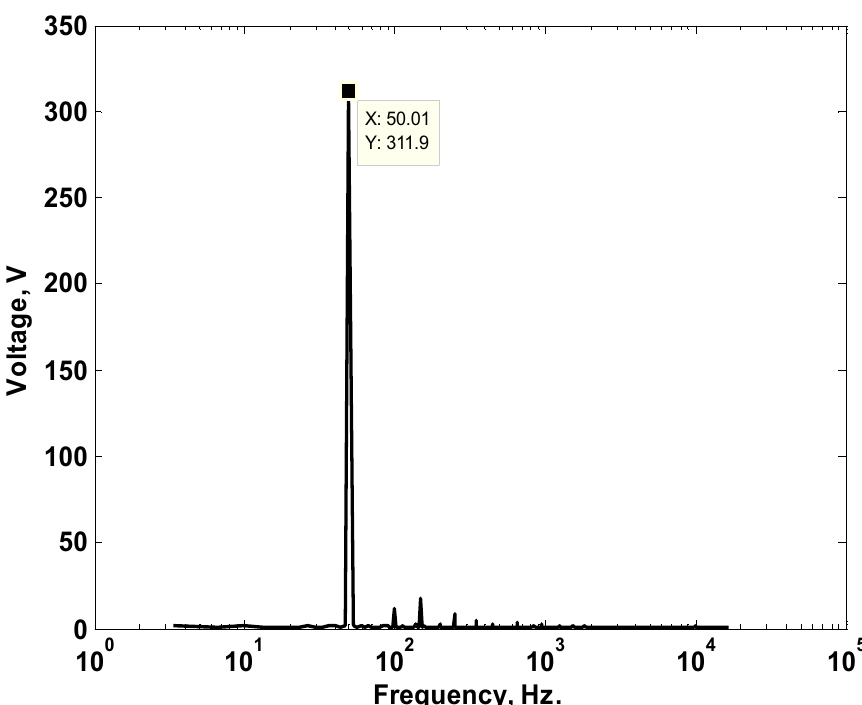
Figure 10. FFT of the Voltage Waveform Shown in Figure 8.